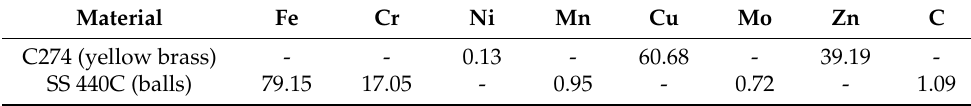
Table 1. Chemical compositions (wt.%) of yellow brass workpieces and stainless steel